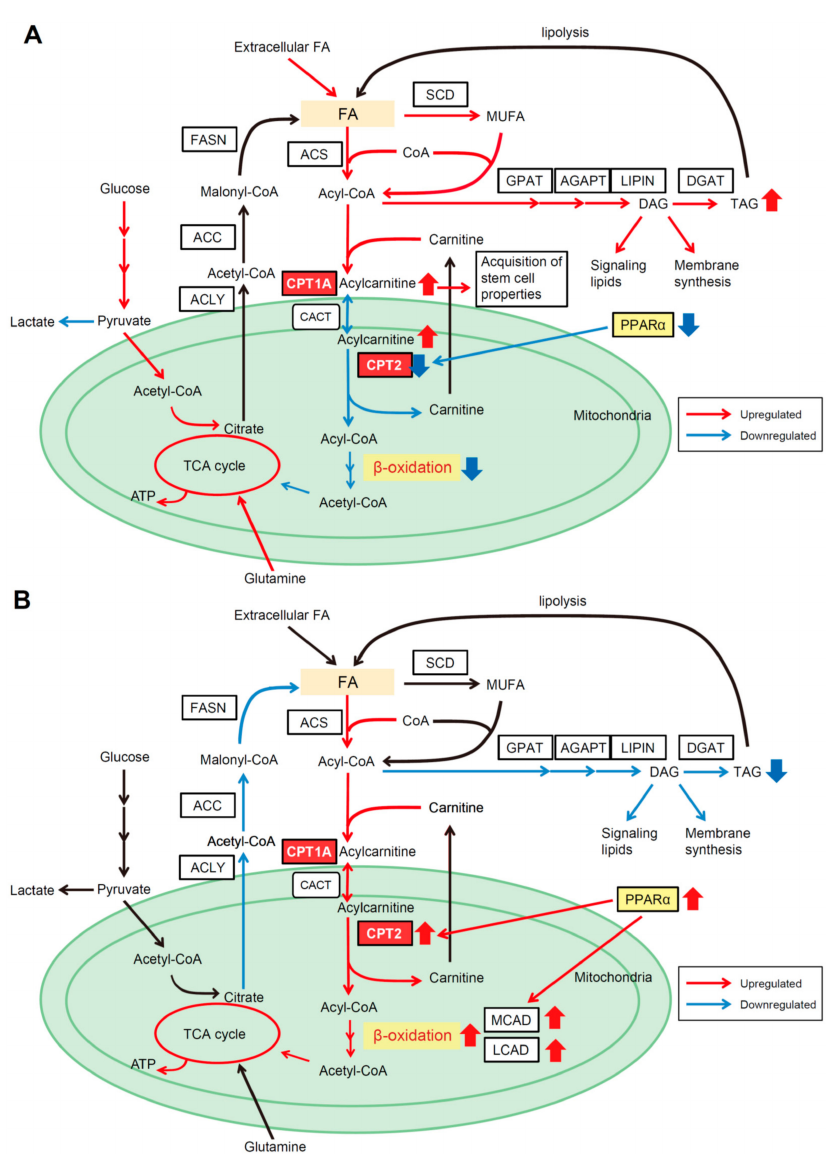
Figure 2. Two distinct lipid metabolic alterations in hepatocellular carcinoma (HCC). ( A ) Lipid metabolic reprograming in obesity- and nonalcoholic steatohepatitis (NASH)-related HCC. Fatty acid β -oxidation (FAO) is suppressed for adaptation to a lipid-rich environment. ( B ) Lipid metabolic reprograming in β -catenin-activated HCC. FAO is activated to fuel